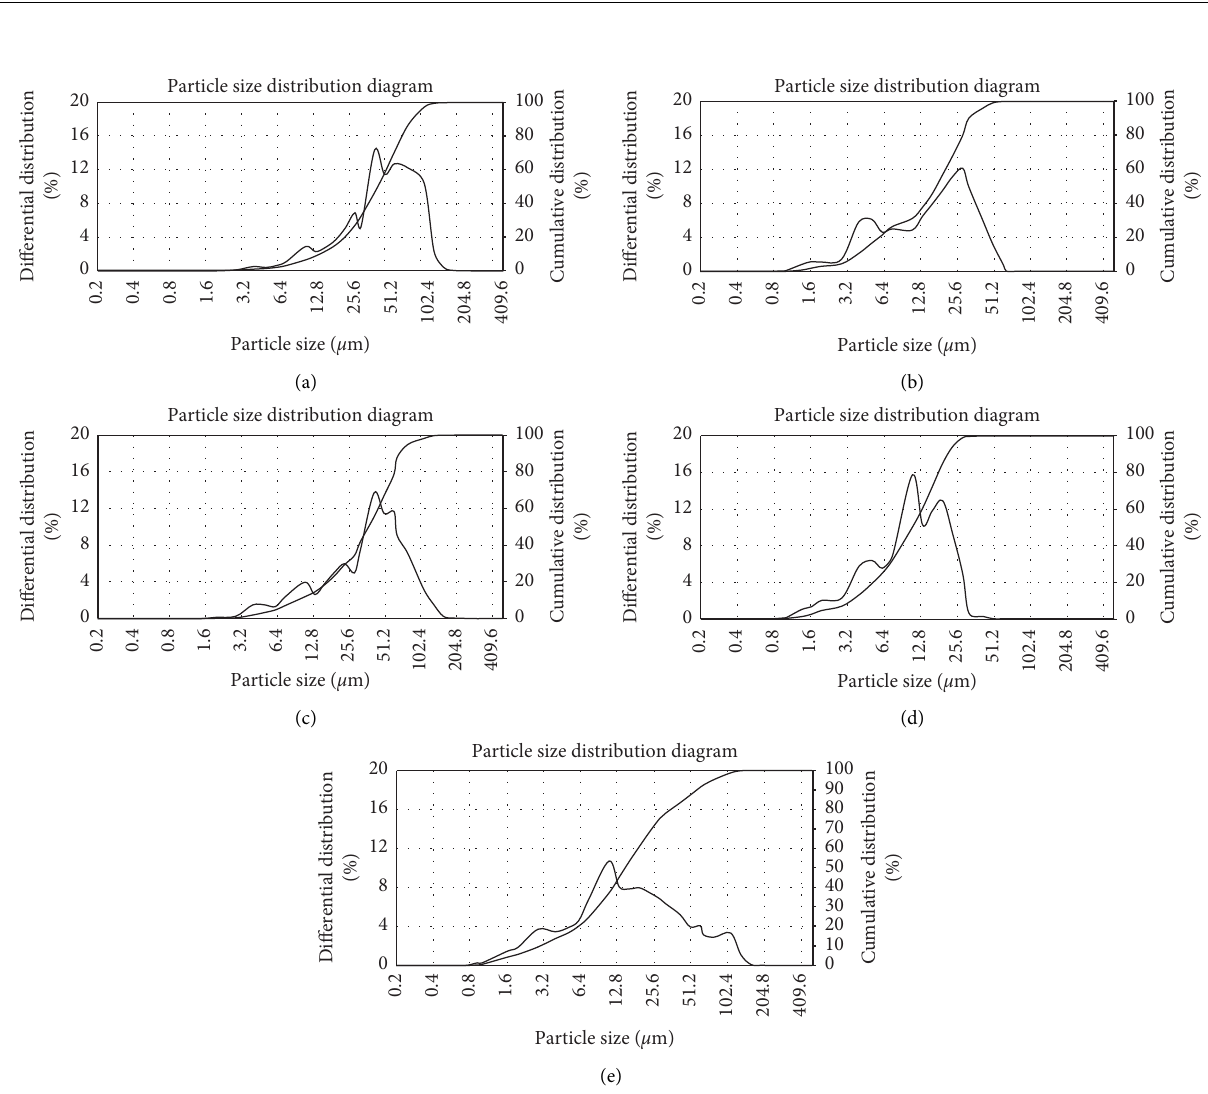
Figure 1: (a) Particle size distribution of microbeads, (b) Particle size distribution of slag, (c) Particle size distribution of fly ash, (d) Particle size distribution of microsilicon and (e) Particle size distribution of the low-density